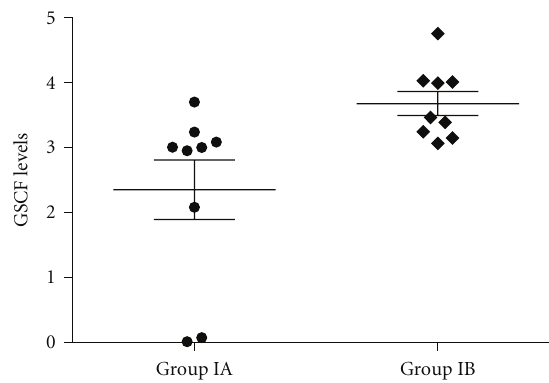
Figure 4: The concentration of GSCF in severe persistent asthma patients in group IA and IB ( P = 0 . 009).